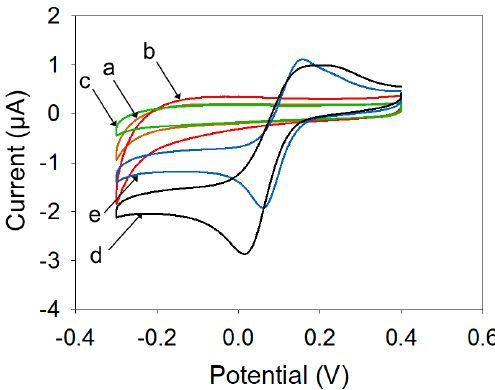
Figure 3. Cyclic voltammograms of the biosensor by using different electrodes ( a , b , c ) before and ( d , e ) after the addition of BPA (100 μ M), ( a ) GCE, ( b ) BCNPs/Nafion/GCE, ( c ) BCNPs/Tyr/Nafion/GCE, ( d ) BCNPs/Tyr/Nafion/GCE, ( e ) Tyr/Nafion/GCE. Scan rate: 0.05 V s -1 .